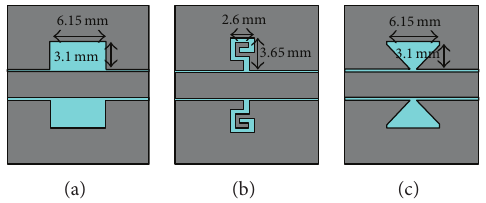
Figure 1: DGS unit cells: (a) rectangular, (b) spiral, and (c) bowtie.